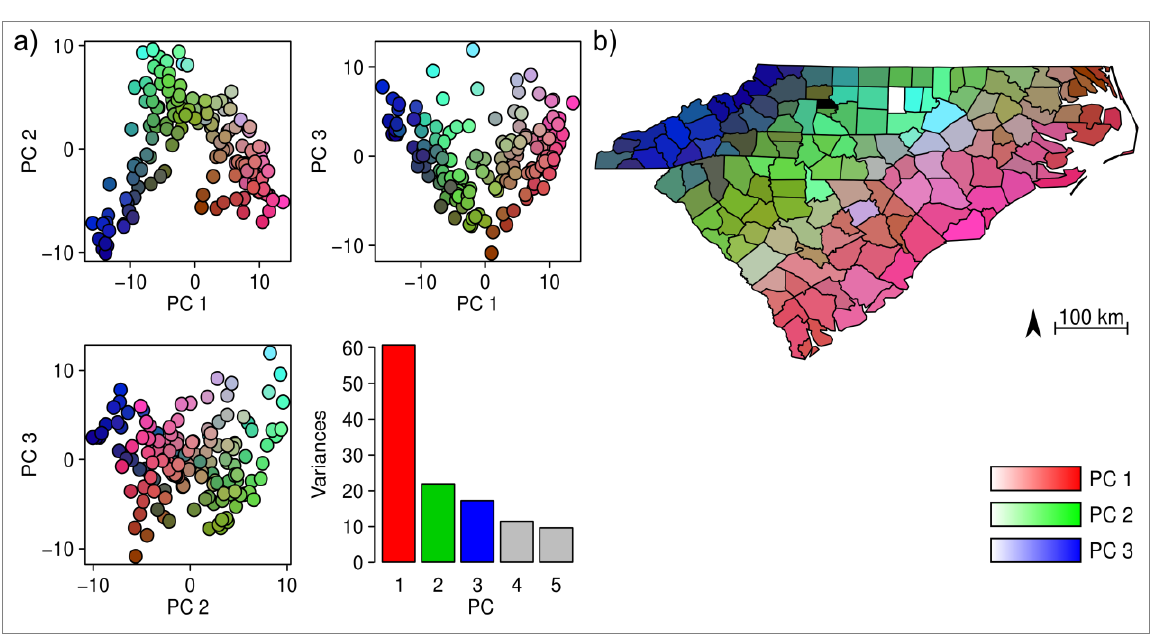
Figure 2. Results of the PCA on the floristic data of North Carolina and South Carolina. ( a ) distribution of the counties in the floristic PCA space and the variances explained by the PCs, and ( b ) spatial distribution of PC-scores across these two